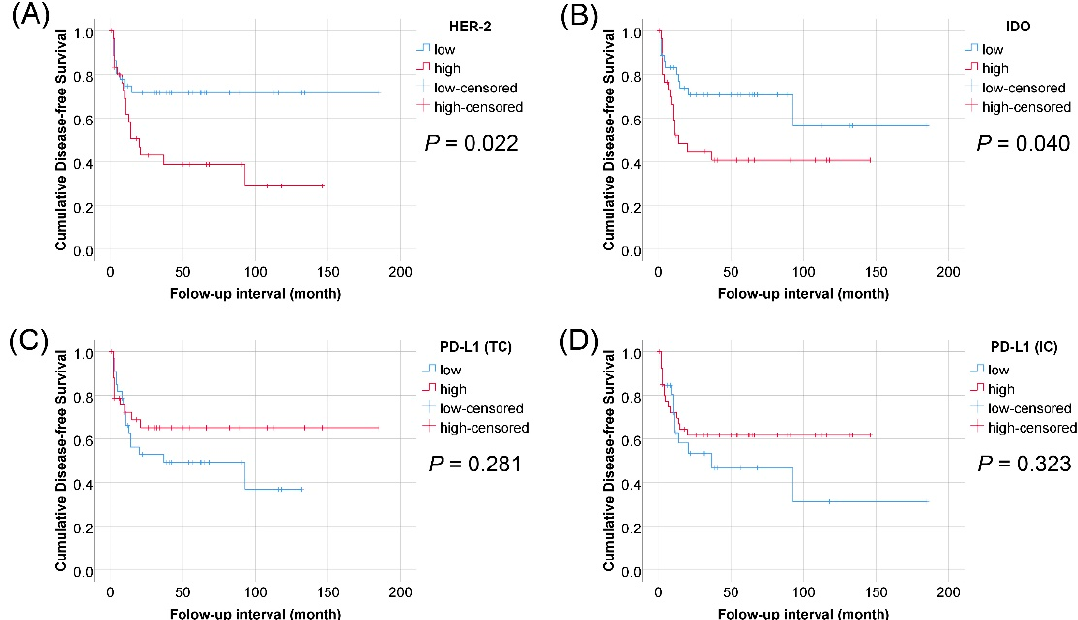
Figure 3. Kaplan–Meier survival curves of disease-free survival in 69 patients with pathologic tumor stage pT2–pT4 urothelial carcinoma of the bladder according to expression of HER2 in tumor cells, IDO in tumor cells, PD-L1 in tumor cells, and PD-L1 in immune cells. ( A ) HER2; ( B ) IDO; ( C ) PD-L1 (TCs); ( D ) PD-L1 (ICs)). Table 4. Multivariate analysis of overall survival and disease-free survival in 69 patients with pathologic tumor stage pT2–pT4 urothelial carcinoma of the bladder.